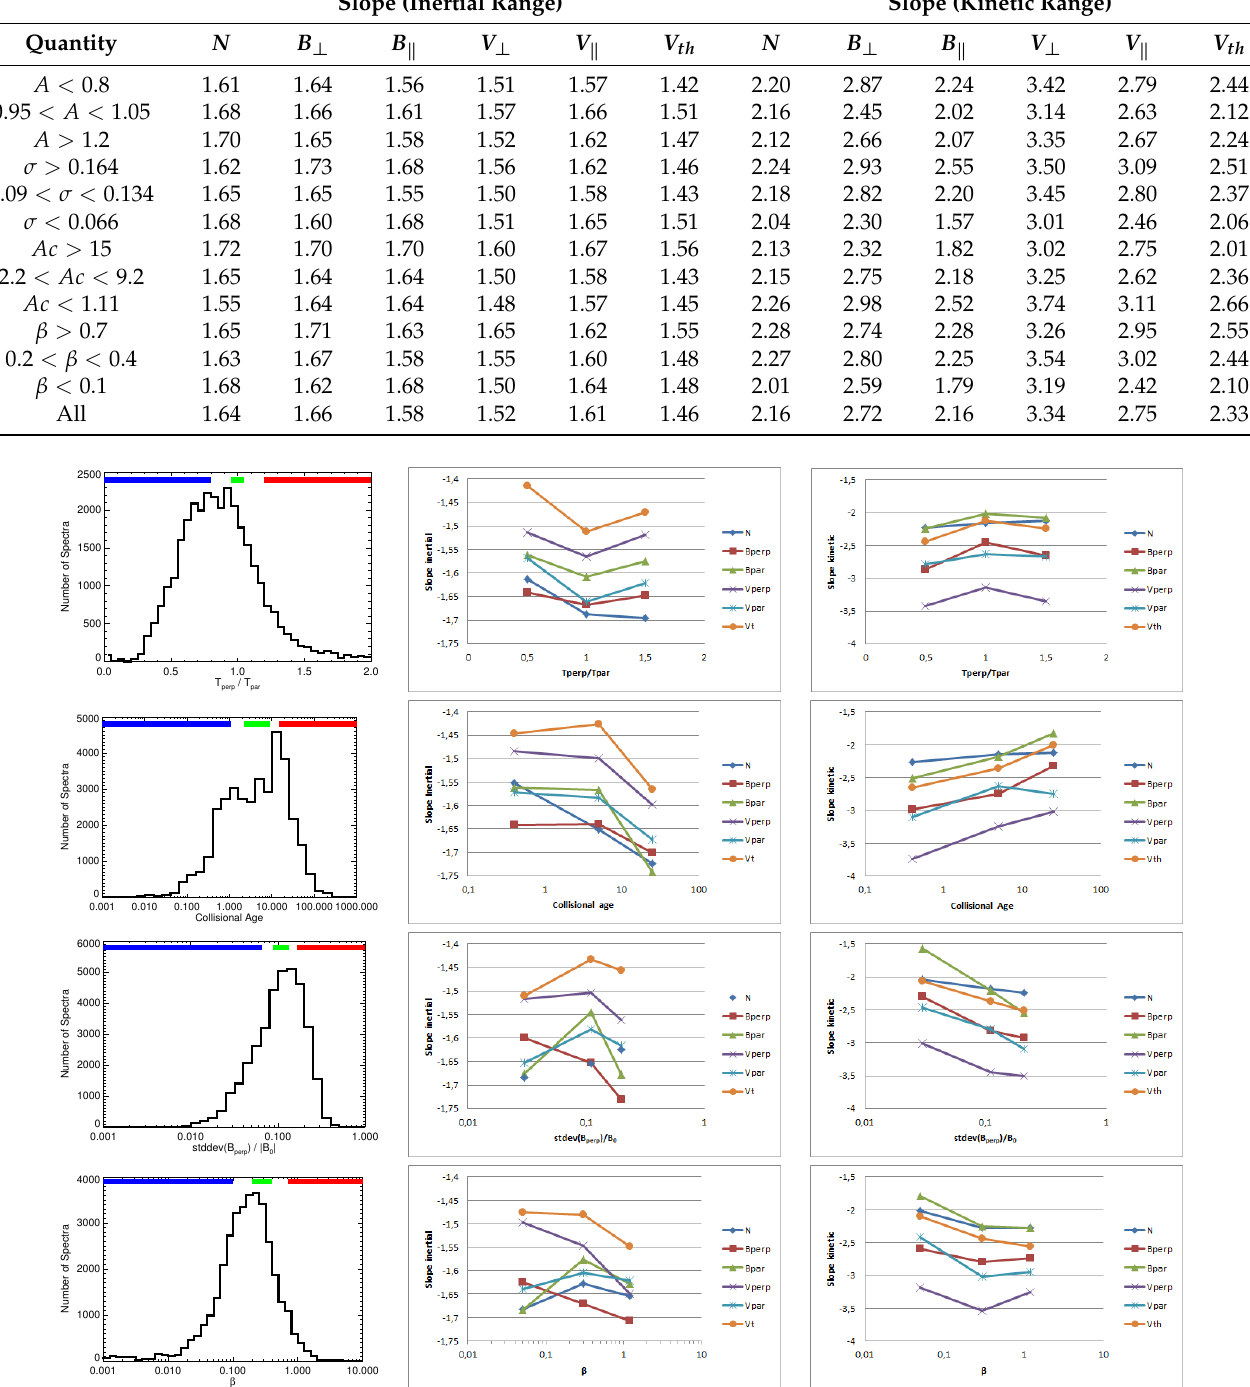
Table 1. Overview of median spectral slopes of different parameters in inertial and kinetic ranges for four groups of quantities. Slope (Inertial Range) Slope (Kinetic Range)